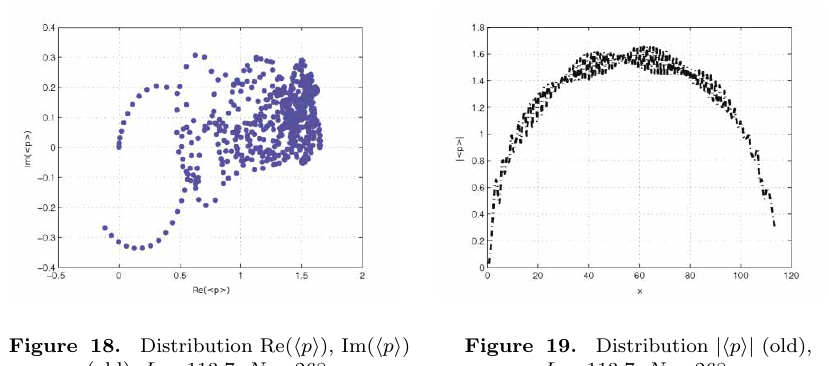
Figure 19. Distribution |(cid:5) p (cid:6)| (old), L = 113 . 7, N =